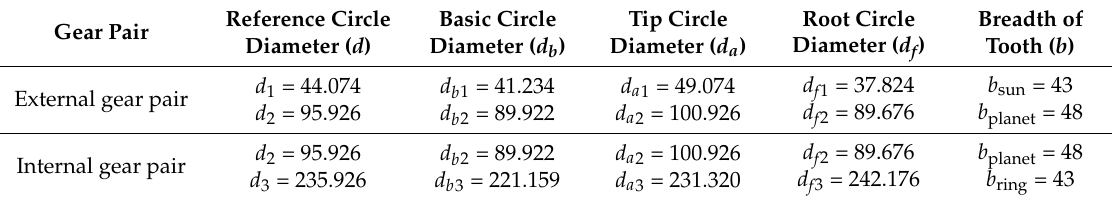
Table 7. Geometric sizes of each gear pair (mm).